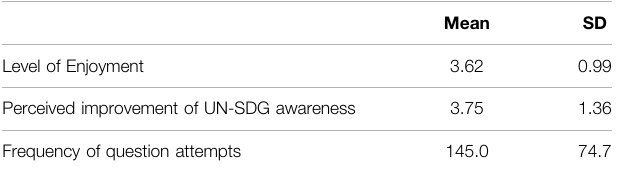
TABLE 3 | Level of enjoyment, perceived awareness, and frequency of question